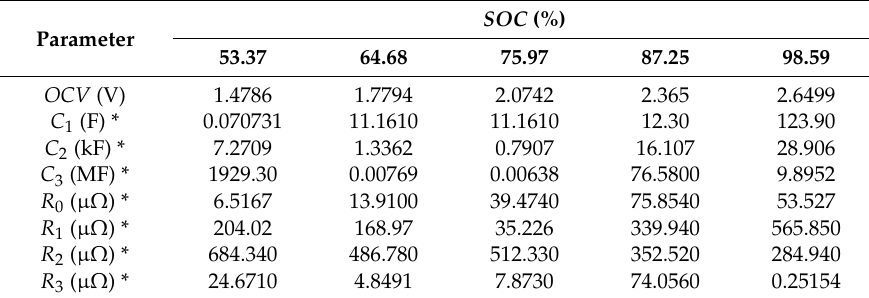
Table A9. Thevenin Model Parameters with i 3 Current